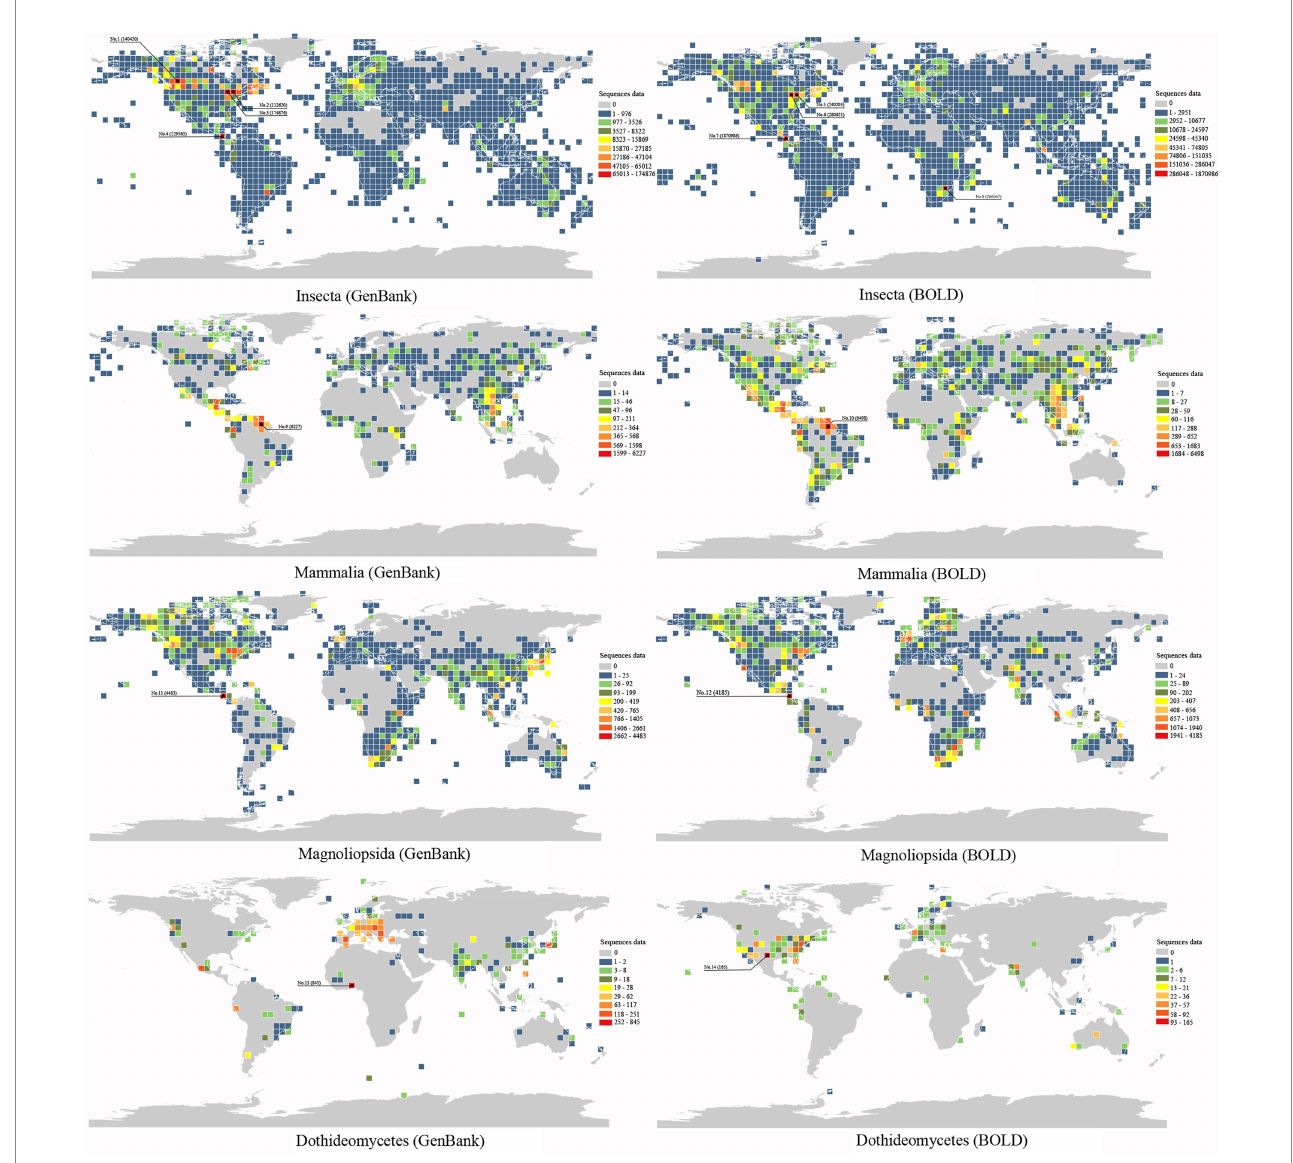
FIGURE 3 The geographical patterns of sequence data of Insecta, Mammalia, Magnoliopsida and Dothideomycetes in the GenBank and BOLD